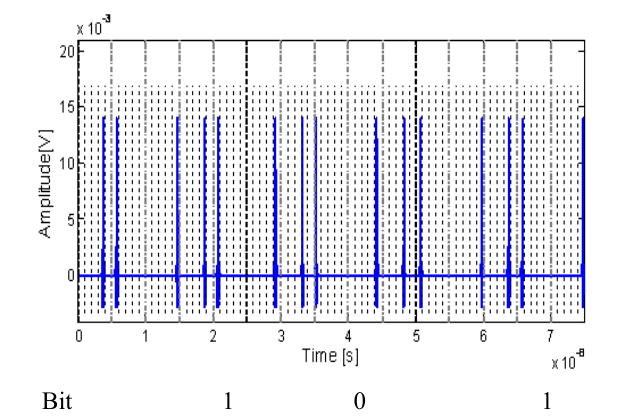
Fig.12. Transmitted signal using fifth derivative Gaussian